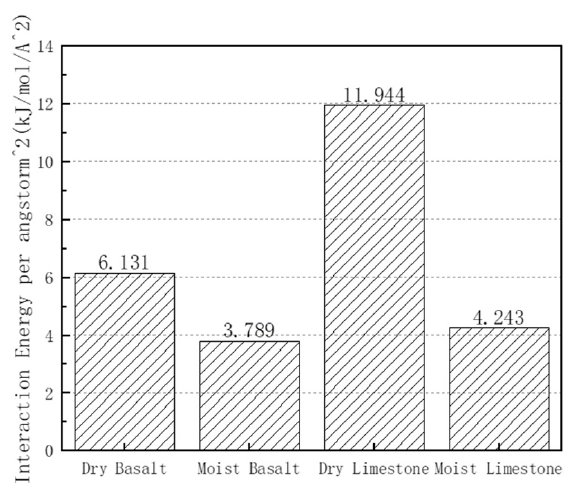
Figure 17. Influence of water on interaction energy density.